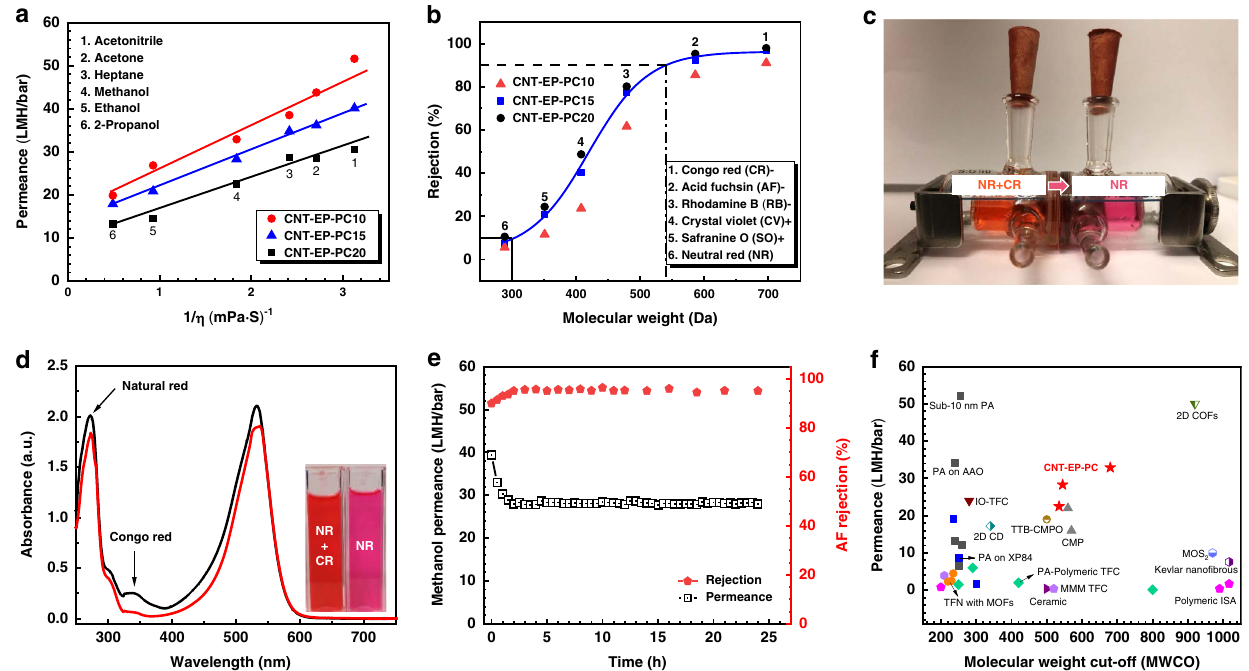
Fig. 5 Performance of organic solvent nano fi ltration and separation of dyes. a Permeances of some common polar and nonpolar organic solvents under the transmembrane pressure drop of 1 bar vs. the inverse solvent viscosity on CNT-EP-PC membranes that have a thickness of 350 nm (CNT-EP-PC10), 416 nm (CNT-EP-PC15), and 528 nm (CNT-EP-PC20). b Rejection of dyes with different molecular weights under the transmembrane pressure drop of 1 bar. c Separation of mixed dyes by a CNT-EP-PC15 membrane through a diffusion cell. The chamber on the left side contained equal concentrations of Natural Red (NR) and Congo Red (CR) dyes, whereas the chamber on the right side was fi lled with pure methanol initially and turned red (NR) after 1 day of diffusion. d UV-vis spectra of the mixed dyes in the left chamber (black curve) and right chamber (red curve) of the diffusion cell in c . e Long-term fi ltration test of the CR/methanol solution on the CNT-EP-PC15 membrane. f Performance comparison of the CNT-EP-PC15 membrane with some best- reported nano fi ltration